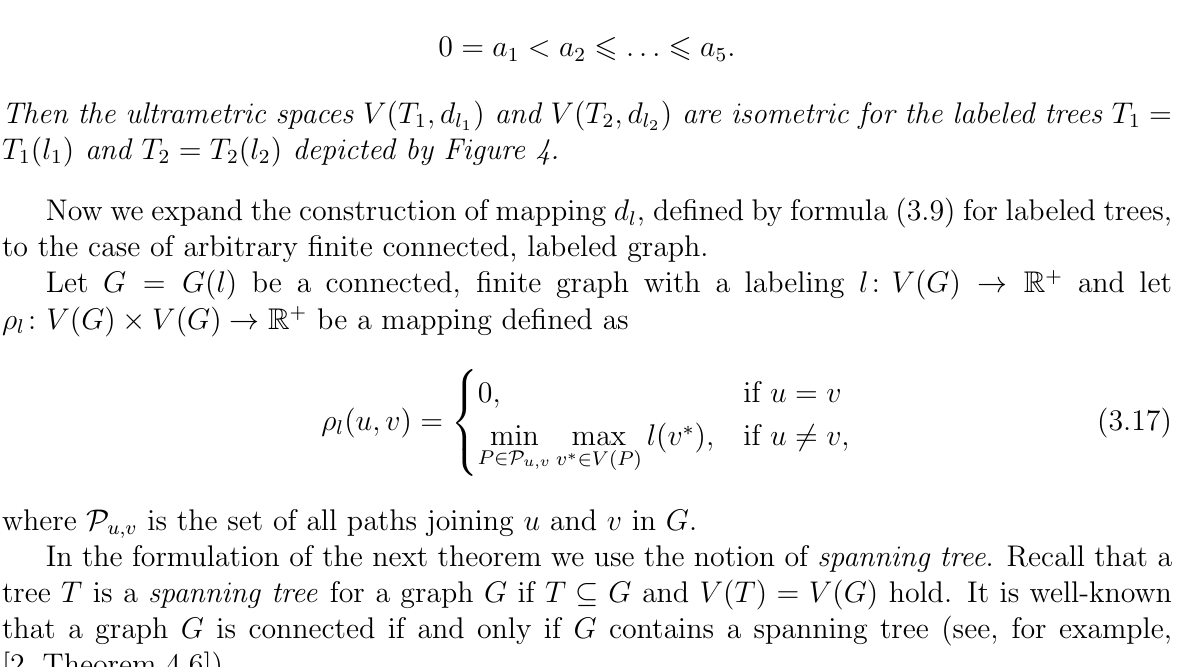
Figure 4: The labeled path T metric